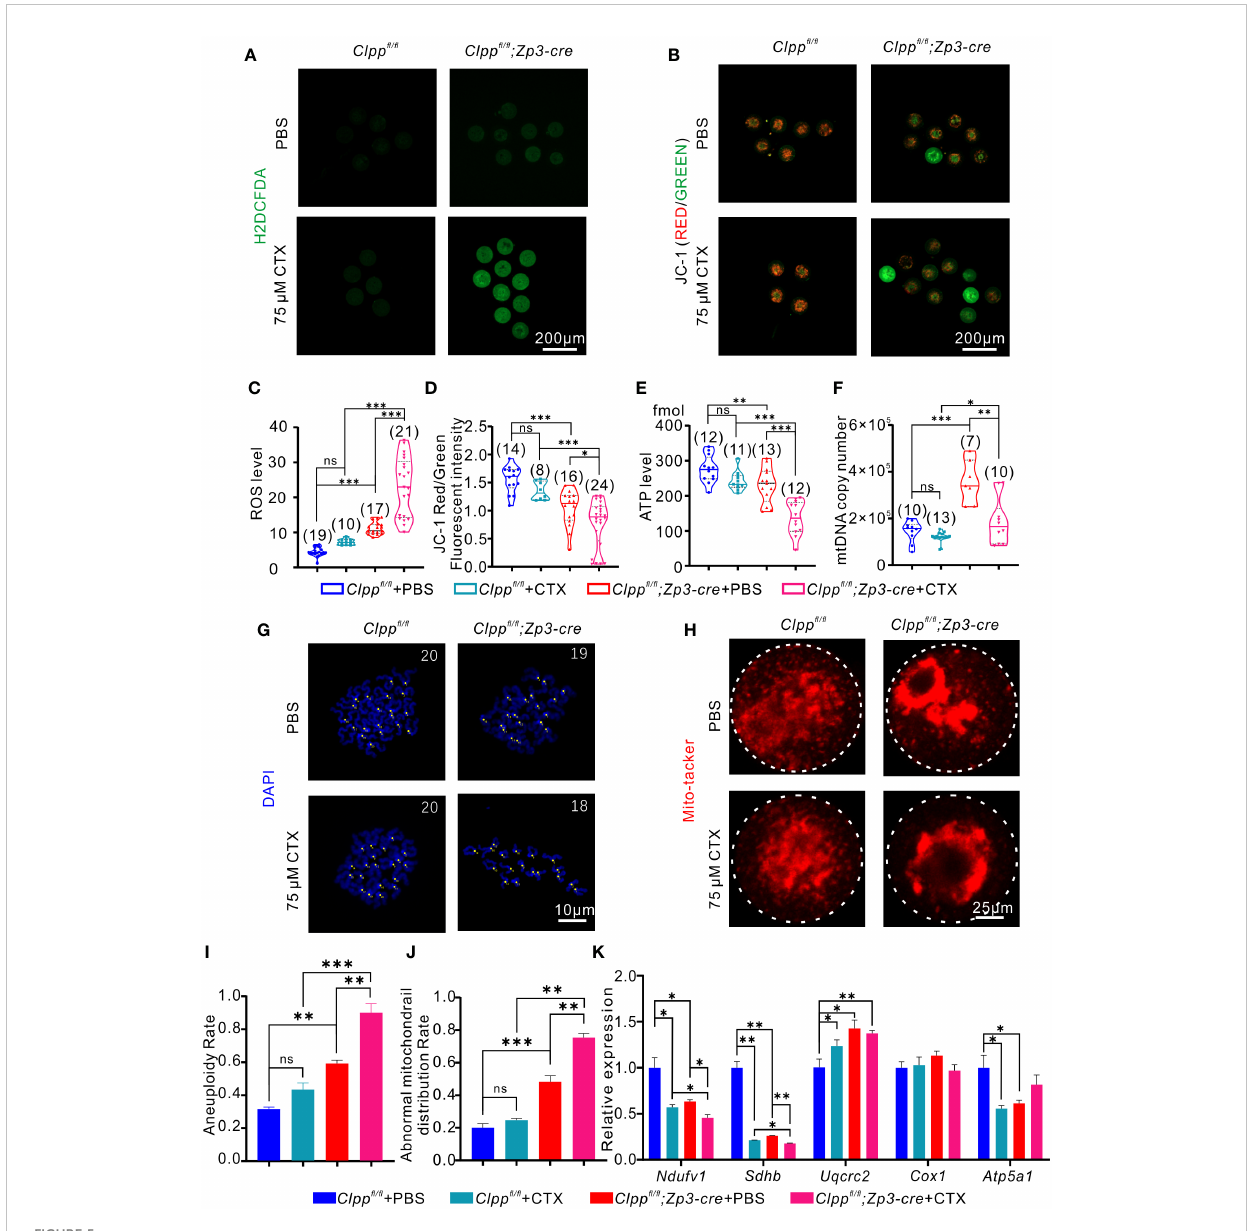
FIGURE 5 CTX induces oocyte de fi ciency by dramatically impairing mitochondrial function. (A) General oxidative stress indicator (Carboxy-H2DCFDA) was used to detect the ROS level in MII oocyte from each group following H 2 O 2 treatment. (B) Fluorescent micrographs of MII oocytes stained by mitochondria-speci fi c probe JC-1. Red fl uorescence represents aggregated Mitochondria and green fl uorescence represents monomeric Mitochondria. (C) The fl uorescence intensity of ROS levels in MII oocyte from each group following H2O2 treatment. (D) Mitochondrial membrane potential (MMP) indicated by the red/green fl uorescence intensity ratio. (E) ATP level and (F) mtDNA copy number was determined in MII oocytes collected from in Clpp fl / fl /Clpp fl / fl +CTX/ Clpp fl / fl ; Zp3 -Cre and Clpp fl / fl ; Zp3 -Cre+CTX mice MII oocytes. (G) Chromosome staining of MII oocytes with DAPI. (H) Mito-tracker staining was applied to exhibit the distribution of oocyte mitochondria. (I) Ratio of chromosomal aneuploidy in oocytes from four groups. (J) Statistical analysis of abnormal mitochondrial distribution in oocytes from four groups after Mito-tracker staining. (K) Expression of respiratory chain genes were assessed using RT – PCR in GV oocytes collected from four groups of female mice. All the oocyte and ovary samples were given one injection at 8 weeks of age. Continue feeding for 14 days after injection. N.S. means no signi fi cant difference; * p < 0.05; ** p <